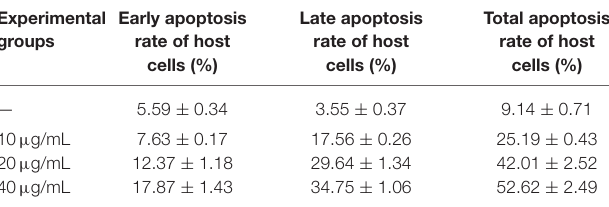
TABLE 2 | Effect of Act D on the host cell apoptosis